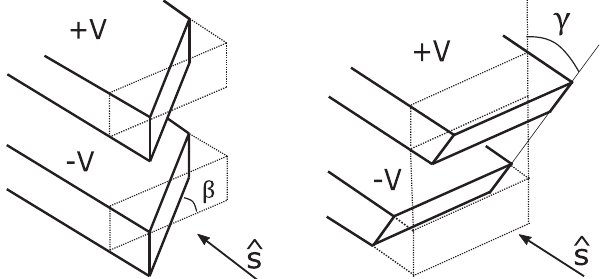
FIG. 6. Creating transverse field gradients in the fringe field region by cutting both electrodes in the ð h ; s Þ plane the ð u r